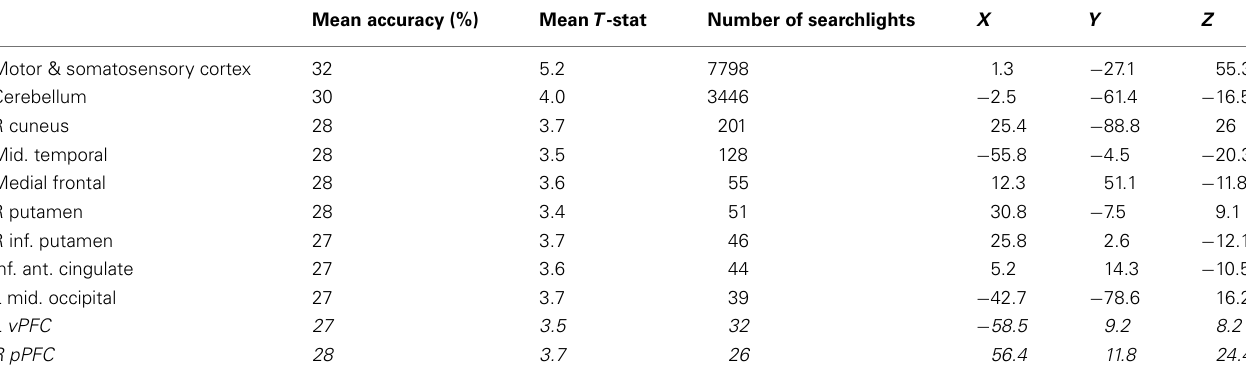
Table 8 |Whole brain response rule searchlight